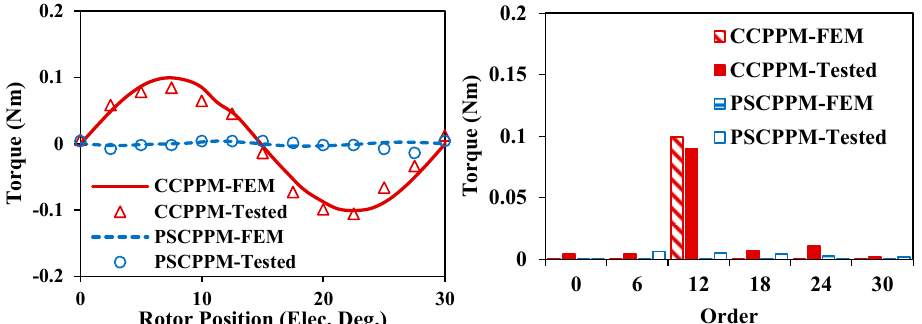
Figure 41. Cogging torque waveforms and spectra of 12s10p machines.